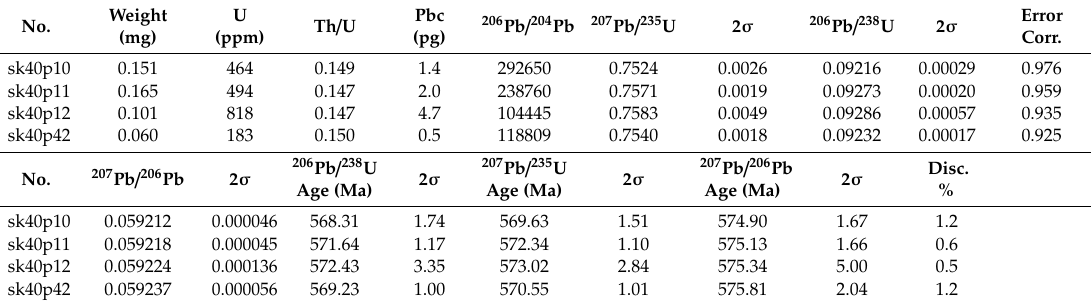
Table 4. U–Pb isotopic data for the LKZ-1 zircon obtained by ID-TIMS.